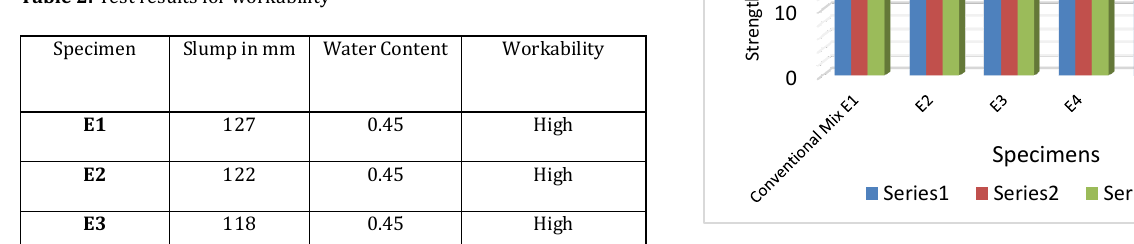
Table 2: Test results for workability